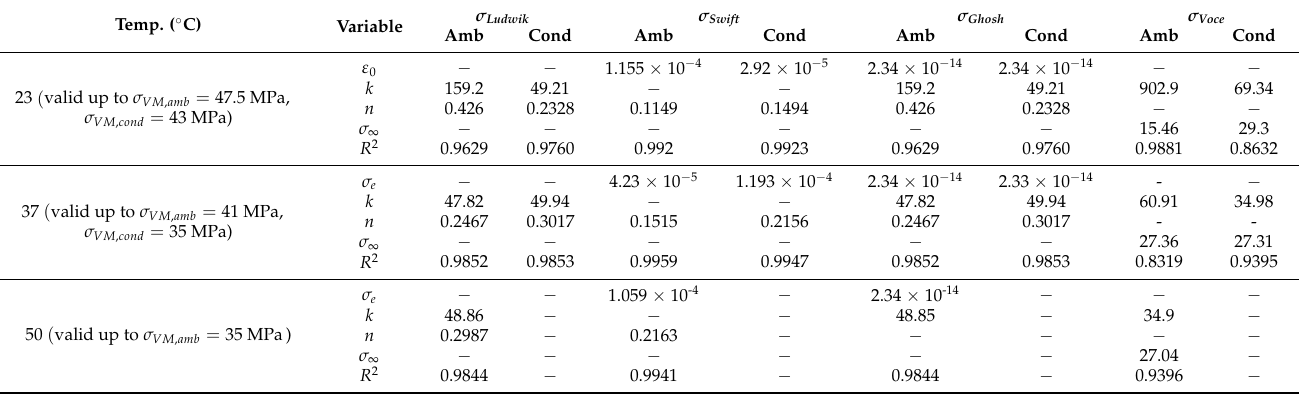
Table A1. Variables of fit to the Ludwik, Swift, and Ghosh models until necking for 23 ◦ C (Ambient and Conditioned), 37 ◦ C (Ambient and Conditioned), and 50 ◦ C (Ambient) including the resulting R 2